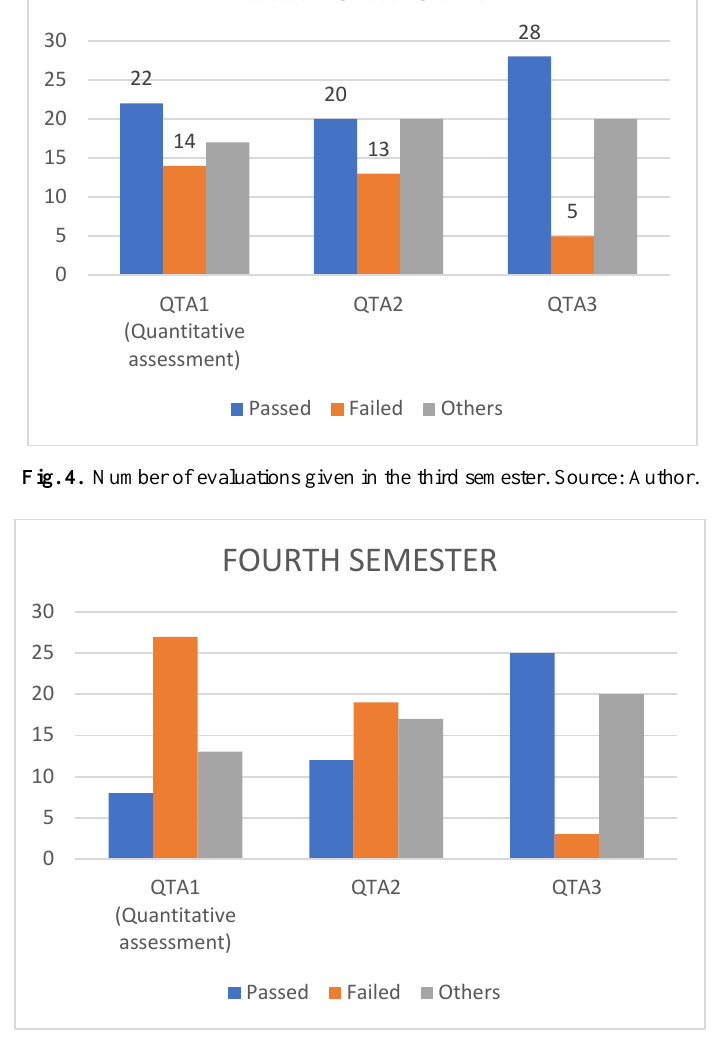
Fig. 5. Number of assessments given in the second semester. Source: